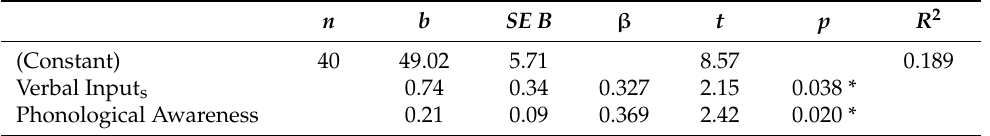
Table 4. Regression analysis (backward elimination) with verbal input (VI s ) and all cognitive skills as independent variables, ELIAS Grammar Test 2 (EGT2) as a dependent variable.